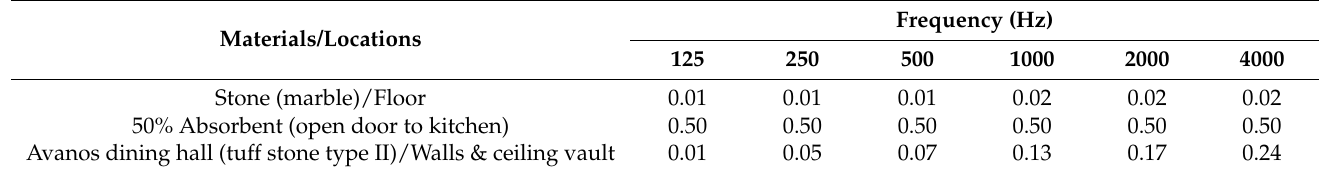
Table 4. Absorption coefficients ( α ) over 1/1 octave bands of the materials applied to the Avanos Dining Hall acoustical